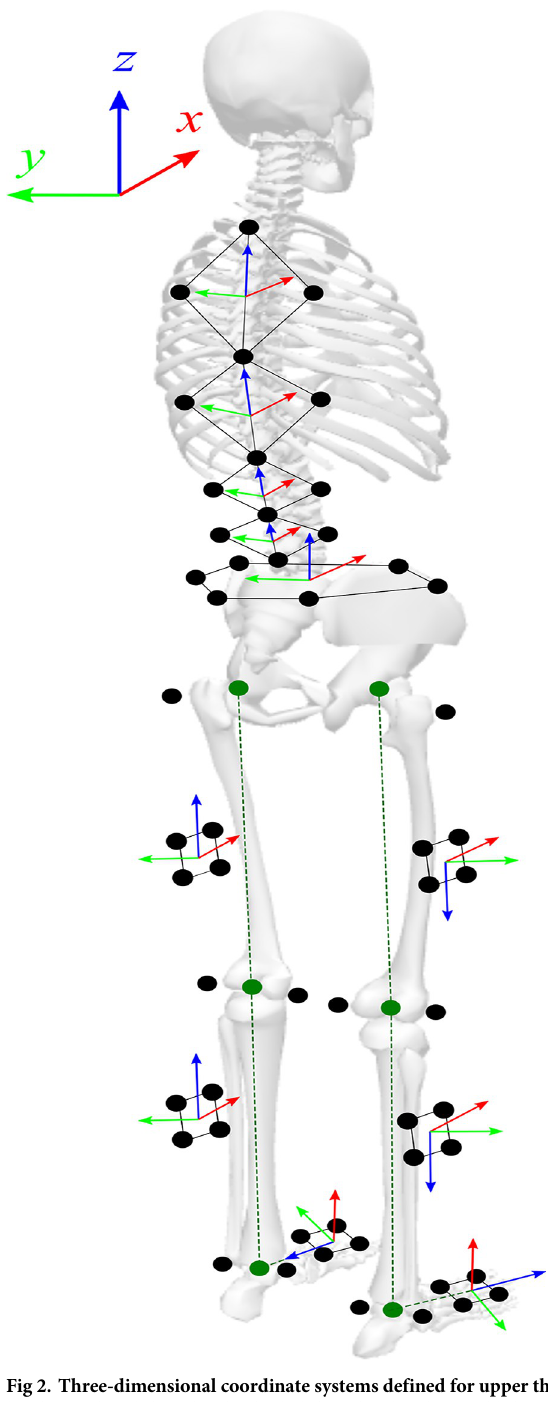
Fig 2. Three-dimensional coordinate systems defined for upper thorax, lower thorax, upper lumbar, lower lumbar, pelvis, left and right thigh, left and right tibia, and left and right foot segments. Local z axes were determined between T1 and T6, T6 and L1, L1 and L3, and L3 and L5 for upper thorax, lower thorax, upper lumbar, and lower lumbar segments, respectively. Cross product of the z axis and the vector defined by the two midpoint markers determined the x axis of each spine segment. Joint angles defined for the upper thorax, lower thorax, upper lumbar, and lower lumbar. The left and right anterior superior iliac spine (ASIS) and posterior superior iliac spine (PSIS) markers defined the local pelvis axes, with the y axis defined between left and right ASIS, and the x axis pointing anteriorly. Anatomical hip, knee, ankle joint axes were projected on thigh, tibia, and foot clusters, respectively, with the local z axis along the long axis of the femur, tibia, and foot, and the local y axis pointing laterally.